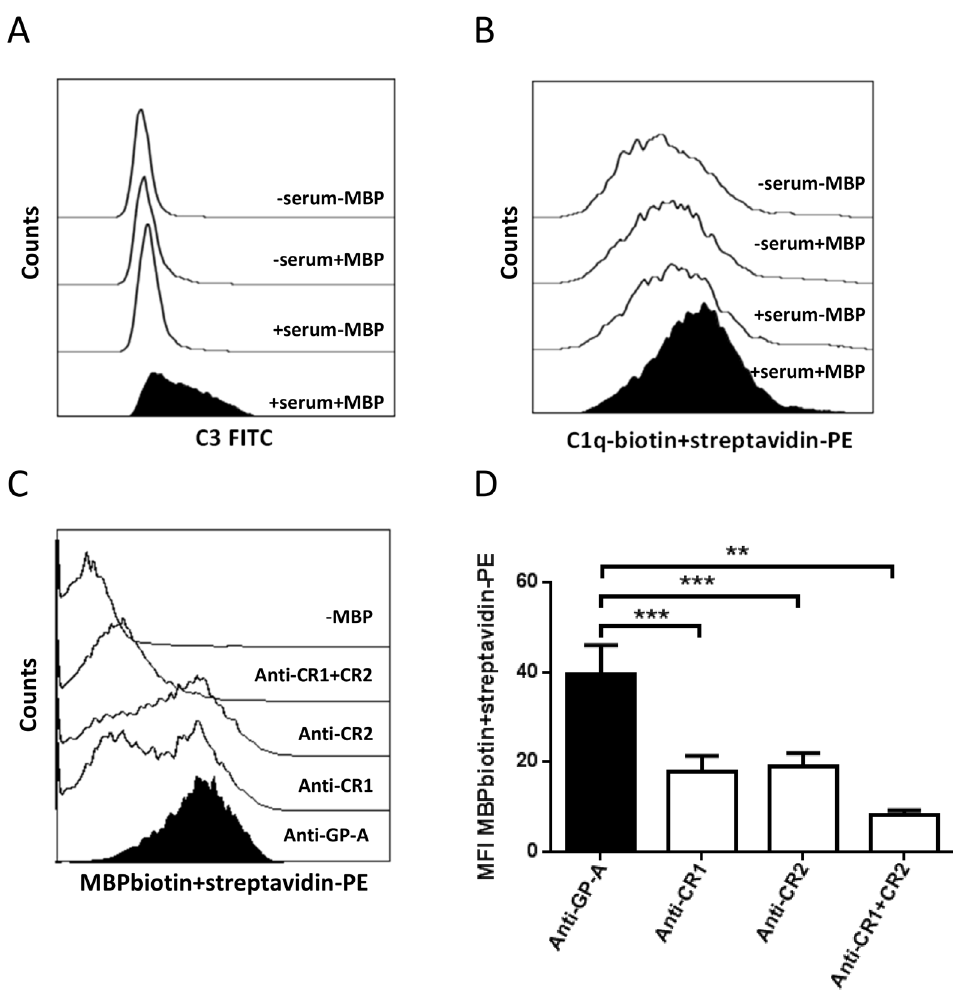
Figure 2. C1q and C3 co-deposit with MBP on B cells, which take up MBP via CR1 and CR2. PBMCs from healthy donors were incubated with or without 30 m g/ml MBP in medium containing normal autologous serum (30% v/v), or in pure medium. The resulting deposition of C3 and C1q on B cells was measured by flow cytometry after 5 min incubation (N=3). Representative histogram plots show A) C3-deposition, and B) C1q- deposition on B cells. C) The binding of MBP was assessed using biotinylated MBP as probe and subsequent staining with streptavidin-PE. Blockade of CR1 or CR2 was achieved by pre-incubation of PBMCs with mAb3D9 and polyclonal sheep anti-human CR2 respectively. Monoclonal anti-glycophorin (GP)-A was used as negative control. D) Mean fluorescence intensity (MFI) values of 5–6 experiments are shown; background values (of samples with no MBP added) have been subtracted. Bars and error bars represent means and SEM. **p , 0.01, ***p , 0.001.